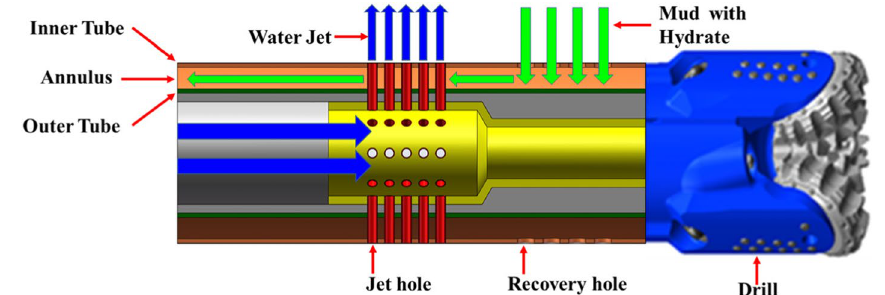
Fig. 12 Schematic diagram of the solid fluidization tool for double-layer pipe